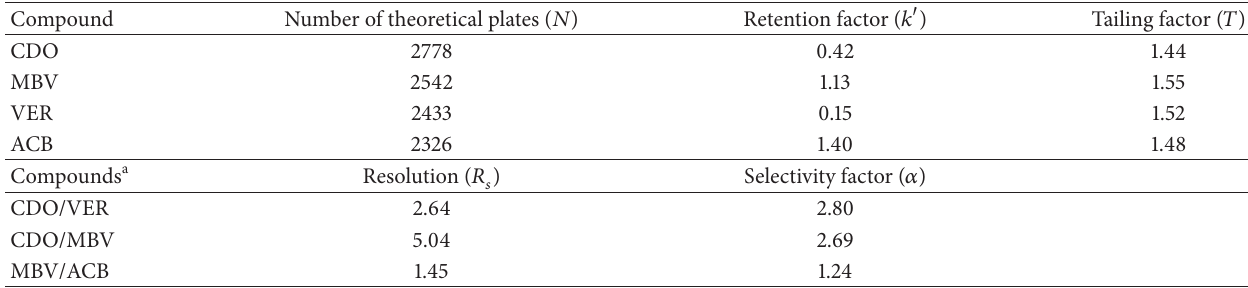
Table 5: Final system suitability test parameters for the proposed method.